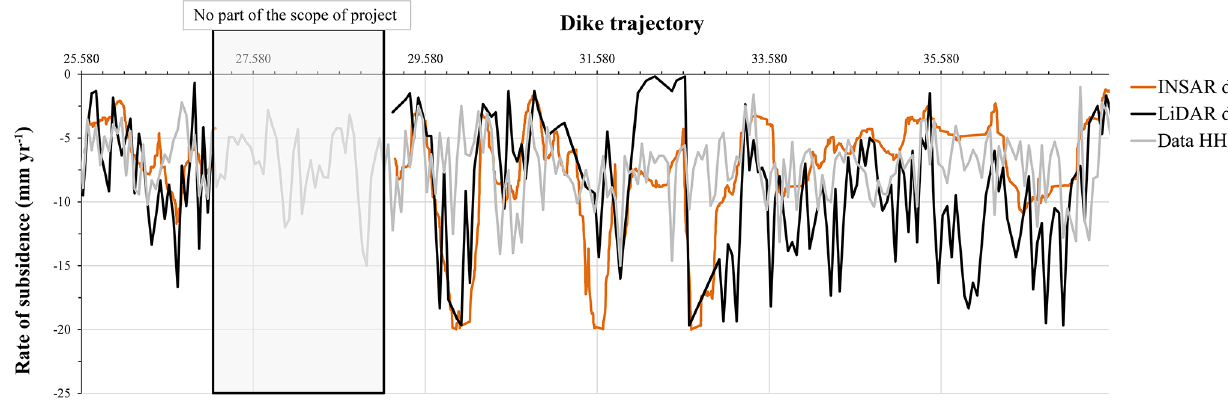
Figure 5. Comparison of subsidence rate determined with different measurement methods and HHSK archive